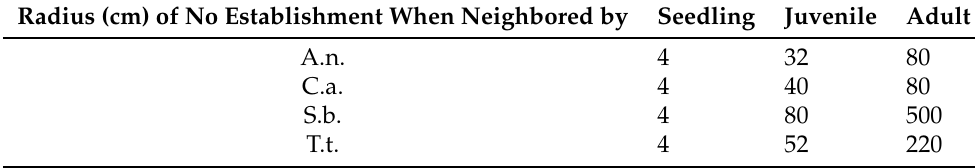
Table A1. Need for space for